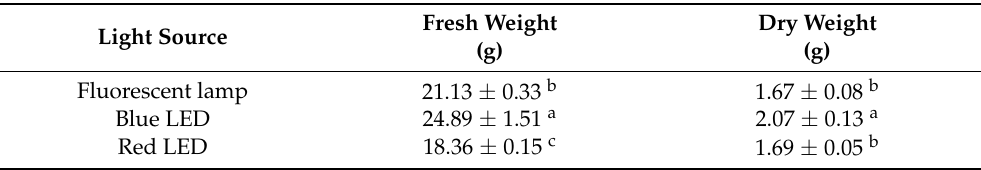
Table 4. Fresh and dry weight of H. corymbosa (L.) Lam plants after 4 weeks of being grown under different light sources at the same light intensity at 100 µ mol · m − 2 · s − 1